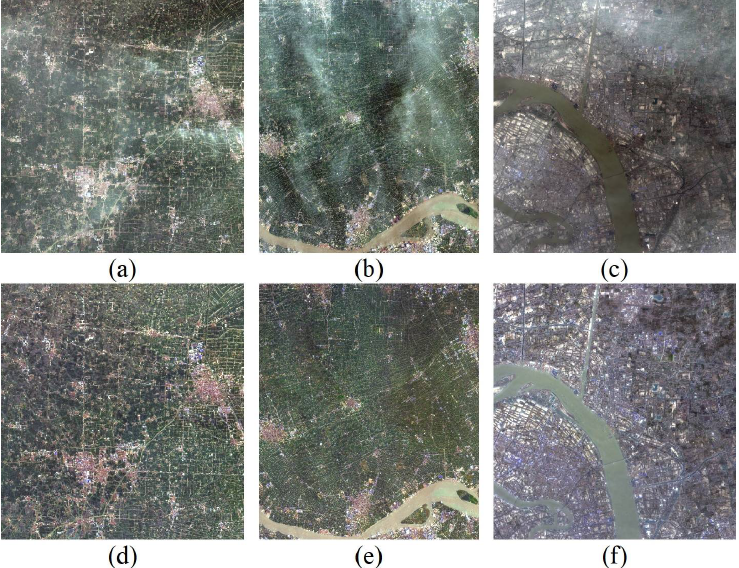
Figure 11. Dehazing results (sub-scenes) of MODEL-T. ( a ) hazy block (path 119, row 037, acquisition date 22 April 2016); ( b ) hazy block (path 119, row 038, acquisition date 22 July 2014); ( c ) hazy block (path 119, row 038, acquisition date 2 February 2016); ( d – f ) dehazed images using MODEL-T.